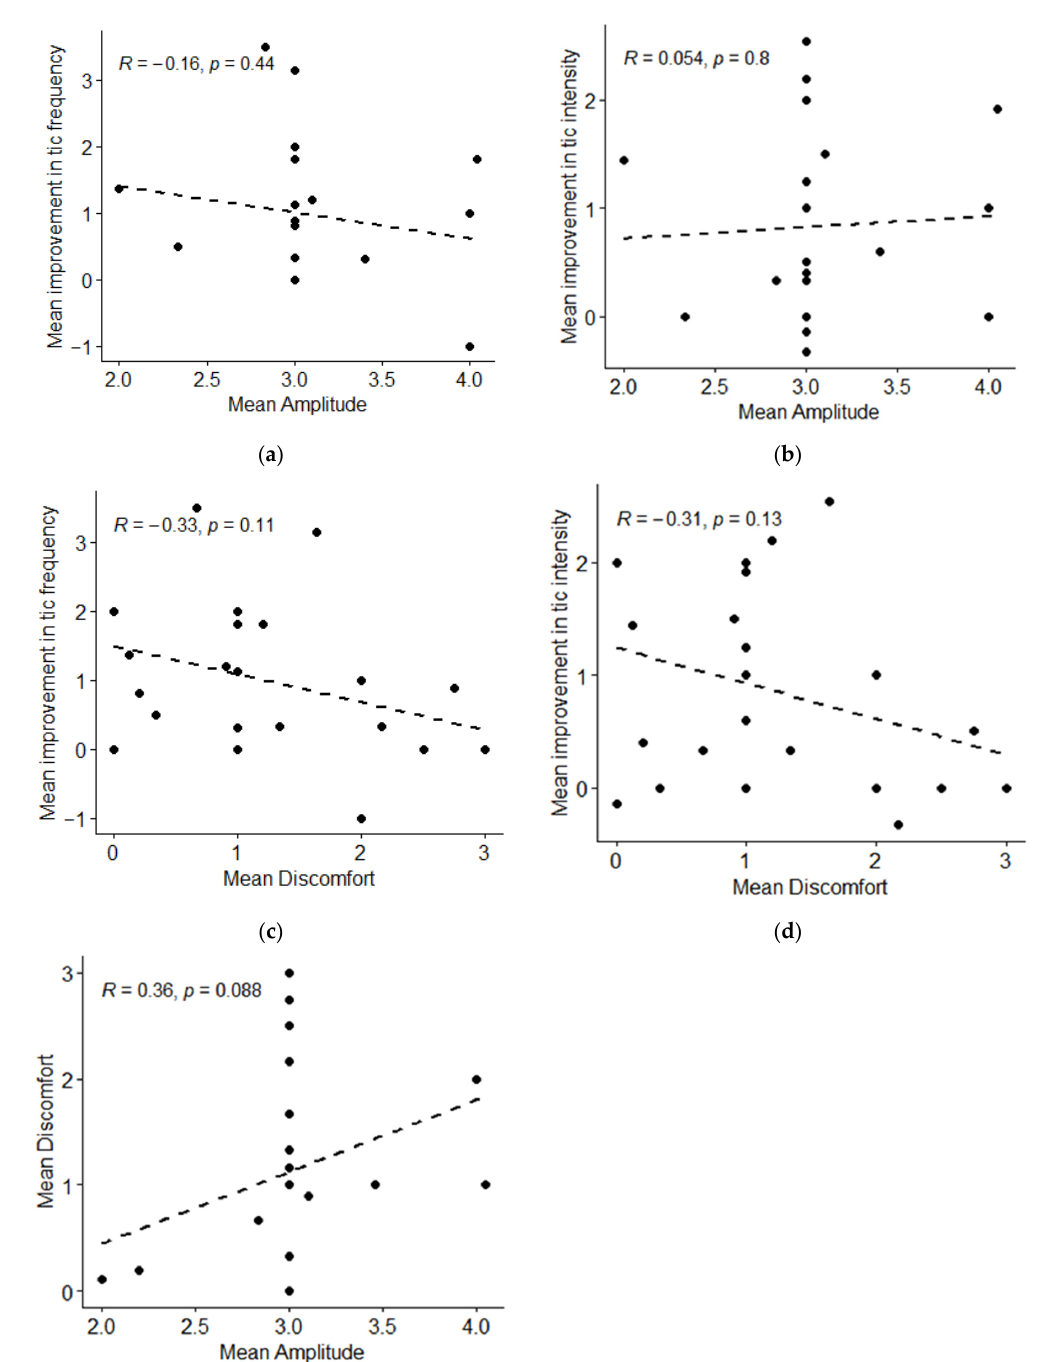
Figure 2. Impact of Stimulation Amplitude and Discomfort on Tic Frequency and Intensity. ( a ) Mean improvement in tic frequency compared with mean stimulation amplitude for each participant (n = 24). ( b ) Mean improvement in tic intensity compared with mean stimulation amplitude for each participant (n = 24). ( c ) Mean improvement in tic frequency compared with mean stimulation discomfort for each participant (n = 25). ( d ) Mean improvement in tic intensity compared with mean stimulation discomfort for each participant (n = 25). ( e ) Mean discomfort compared with mean amplitude for each participant (exploratory analysis) (n =